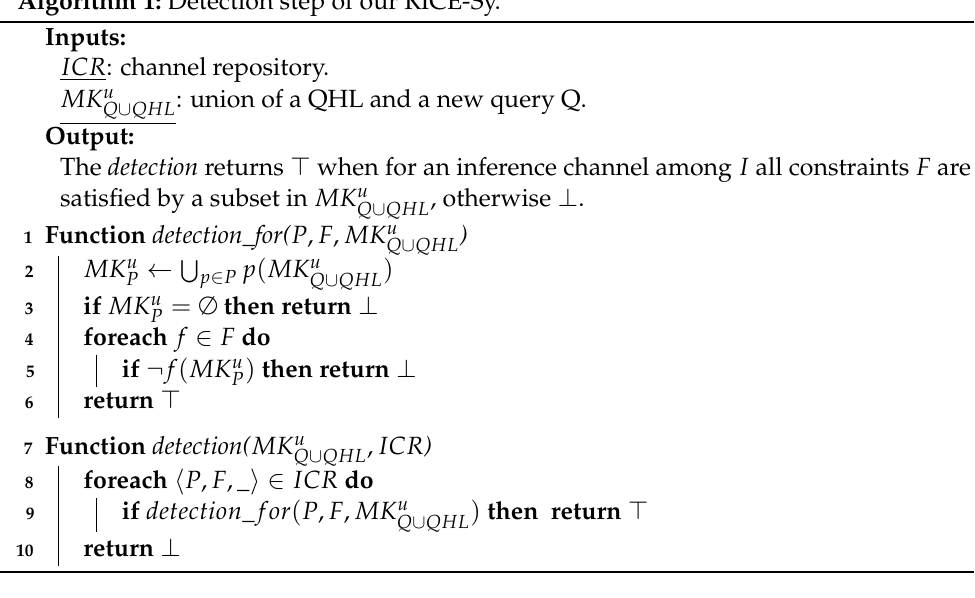
Algorithm 1: Detection step of our